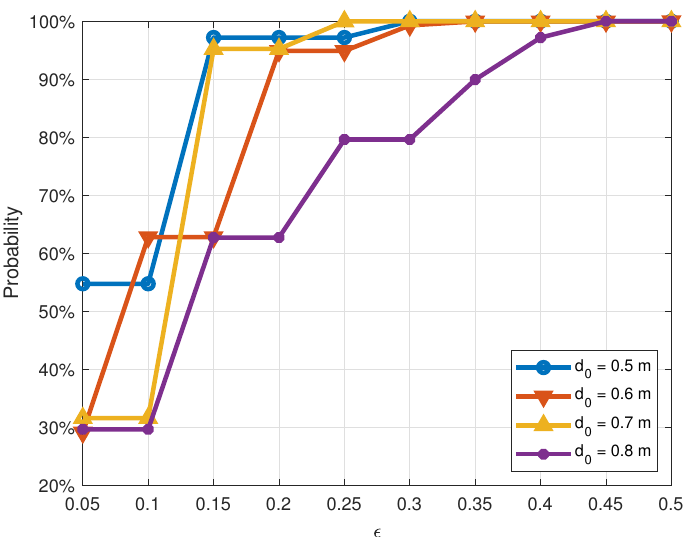
Figure 11. Cumulative distribution function of normalized error (cid:101) at different